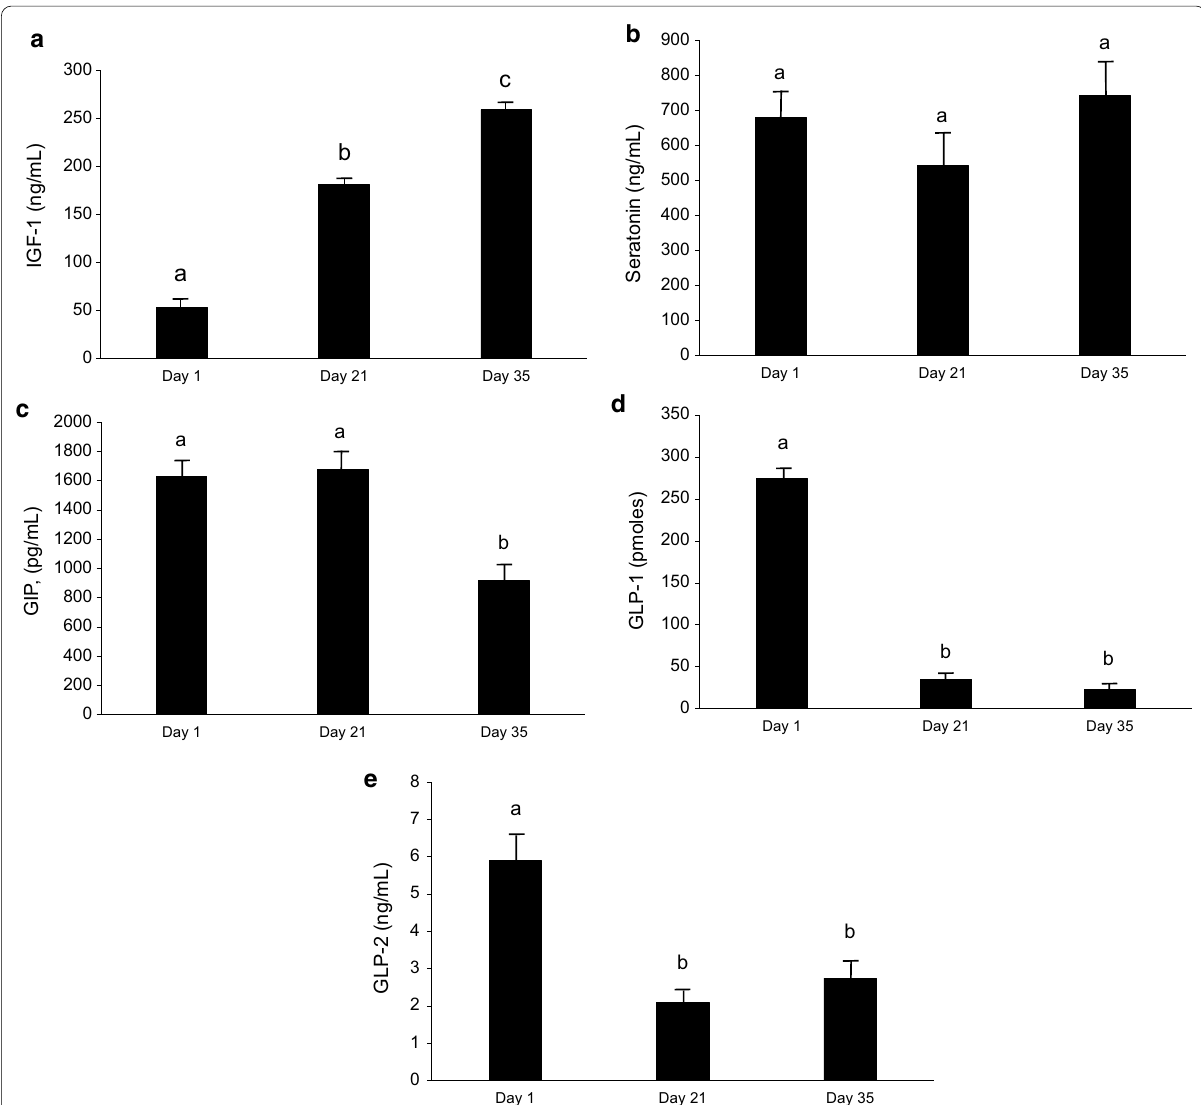
Fig. 2 Plasma peptide concentrations in pigs at day 1, day 21 and day 35 of age. a Plasma Insulin-like growth factor 1 (IGF-1). Significant age effect ( P < 0.0001); significant sow effect ( P < 0.0001). b Plasma Seratonin. Significant sow effect ( P < 0.0001) and age sow effect ( P < 0.0001). c Plasma × Gastric inhibitory peptide (GIP). Significant age effect ( P < 0.0001), sow effect ( P < 0.0001) and age sow effect ( P < 0.0001). d Plasma Glucagon-like × peptide 1 (GLP-1). Significant age effect ( P < 0.05), sow effect ( P < 0.01) and age sow effect ( P < 0.01). e Plasma Glucagon-like peptide 2 (GLP-2). × Significant age effect ( P < 0.0001) and age sow effect ( P < 0.001). Legend: Bars represent means and error bars represent standard errors. Means × not sharing a common superscript letter are significantly different for age (n 48; P < 0.05 ) =